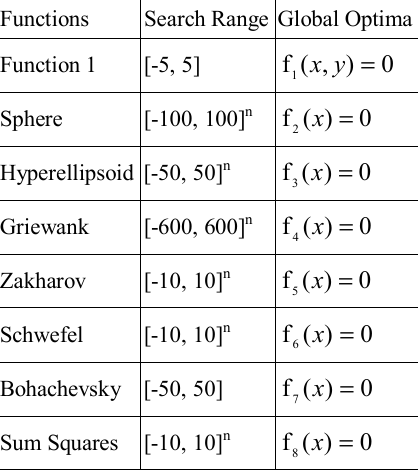
Table 1. Details of benchmark functions.